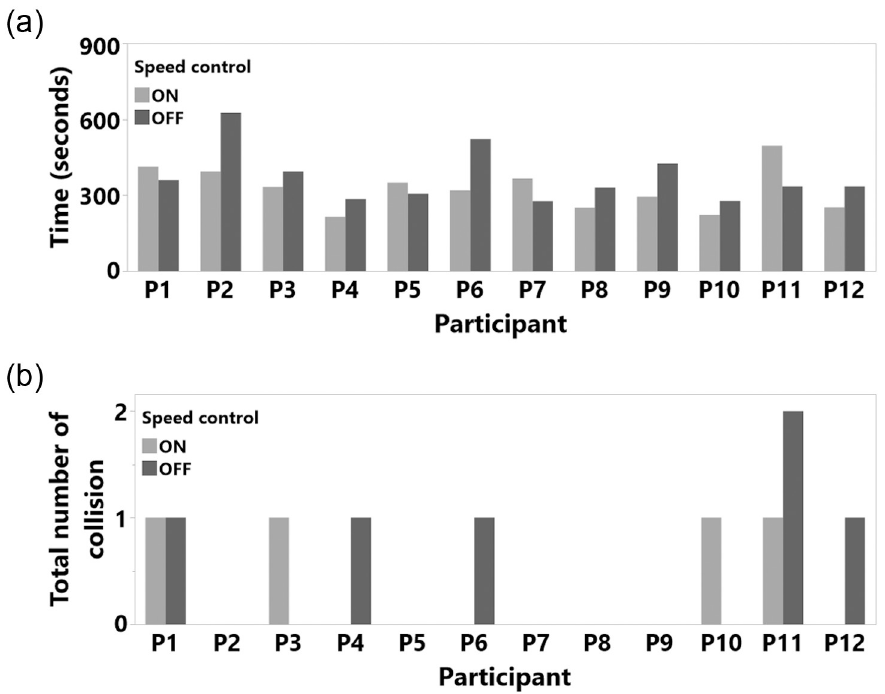
Fig 17. Study 2 participant results (a) total task completion time and (b) total number of collision.